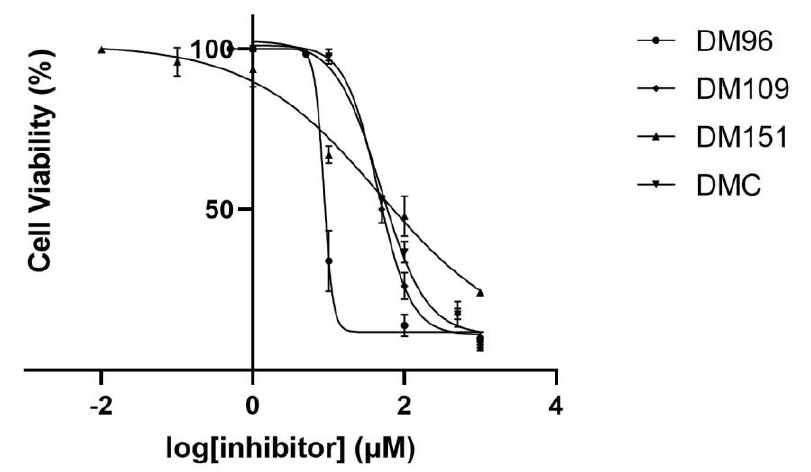
Figure 4. Concentration–response curves of the cytotoxicity of the most potent inhibitors DM96, DM109, DM151, and DMC against DU-145. The data were analyzed using the GraphPad Prism version 8.